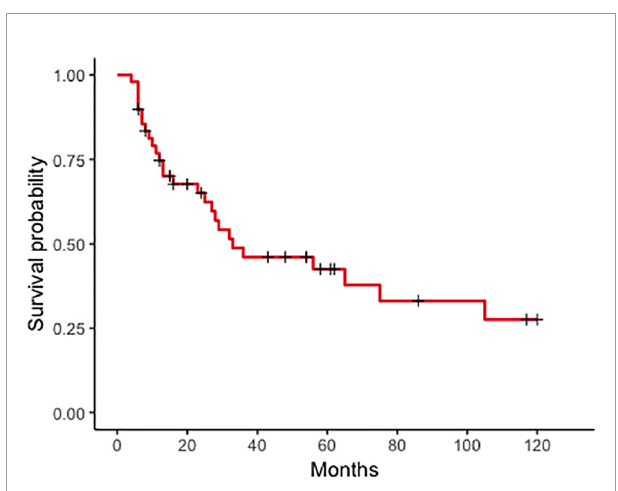
FIGURE 1 | Peritoneal metastases from breast cancer. Kaplan – Meier curves plotted for overall survival in 49 patients with peritoneal metastases from breast cancer at 120